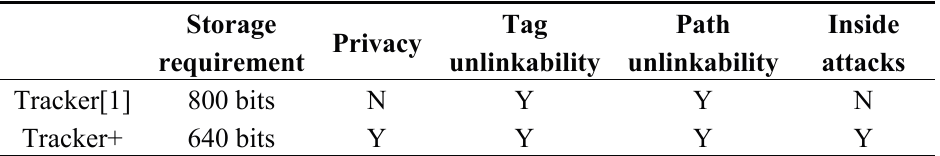
Table 1. Comparisons of Tracker and